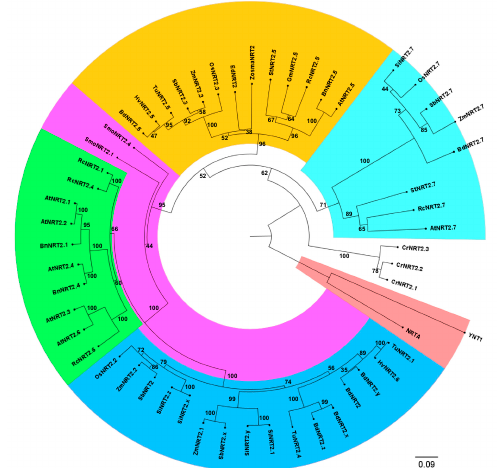
Figure 2. Phylogenetic reconstruction of the NRT2 protein family. Unrooted neighbor-joining tree based on a set of 54 amino acid sequences of the NRT2 proteins identified as the best GenBank and Phytozome BLAST hits using representative members from each taxonomic group. The percentage of trees in which the associated taxa clustered together is shown next to the branches (1000 bootstrap replicates). The accession numbers of each protein in the NCBI included in the analysis were: Zostera marina (ZosmaNRT2, KMZ59016); Arabidopsis thaliana (AtNRT2.1, O82811; AtNRT2.2, Q9LMZ9; AtNRT2.3,